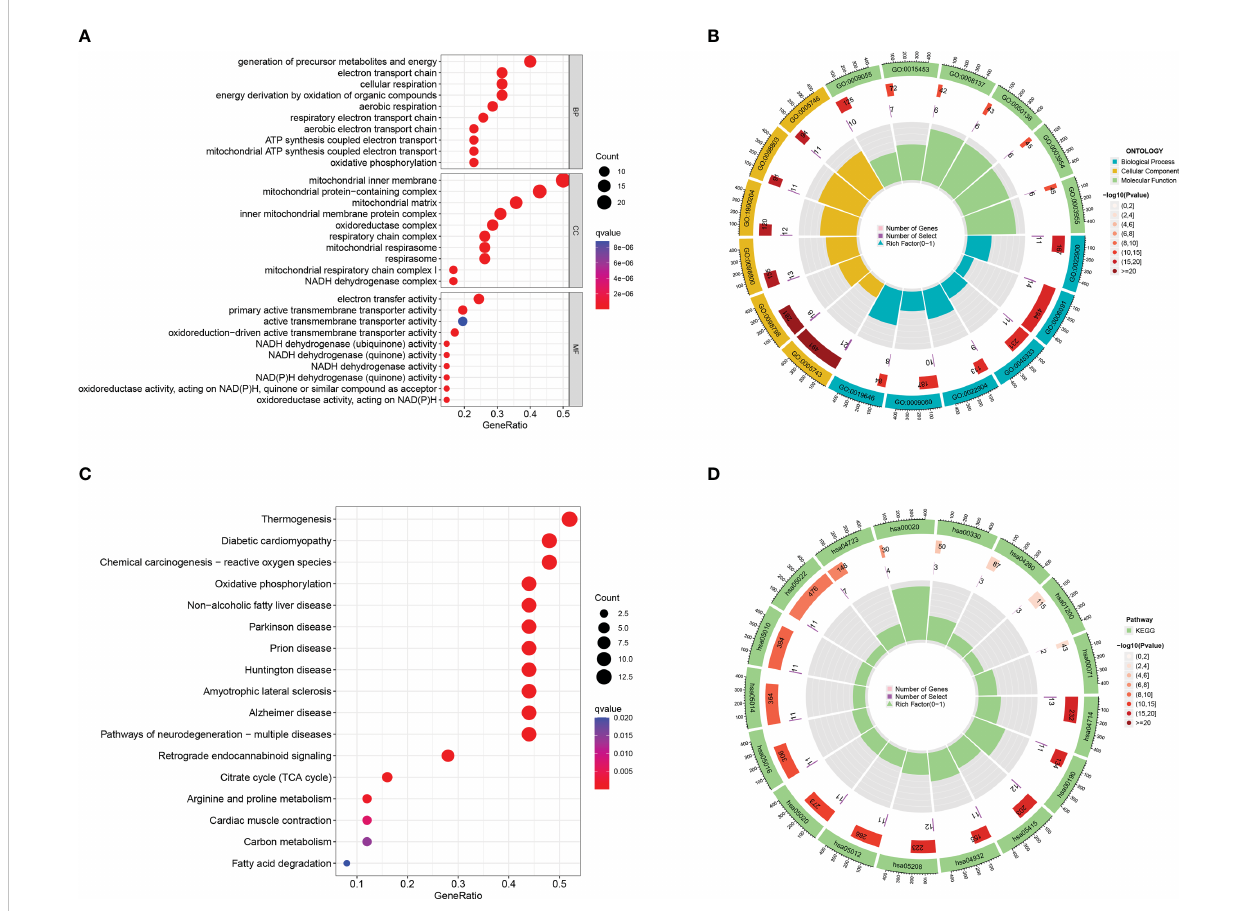
FIGURE 2 GO and KEGG enrichment analysis of mitochondria-associated differentially expressed genes. (A) bubble plot of GO enrichment analysis of 47 mitochondria-associated differentially expressed genes; (B) loop of GO enrichment analysis; (C) bubble plot of KEGG enrichment analysis of 47 mitochondria-associated differentially expressed genes; (D) loop of KEGG enrichment